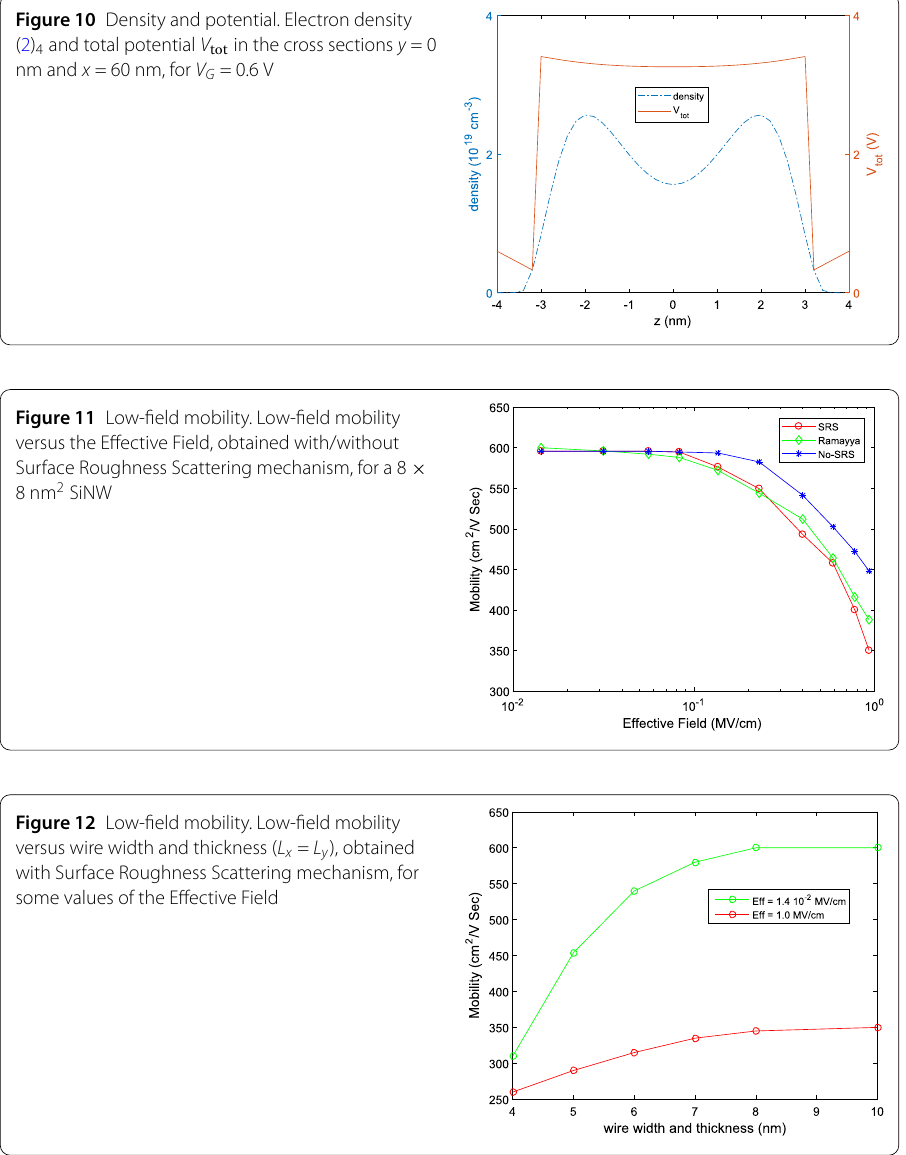
Figure 10 Density and potential. Electron density (2)